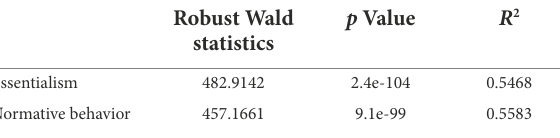
TABLE 3 Significance of the indicators for the